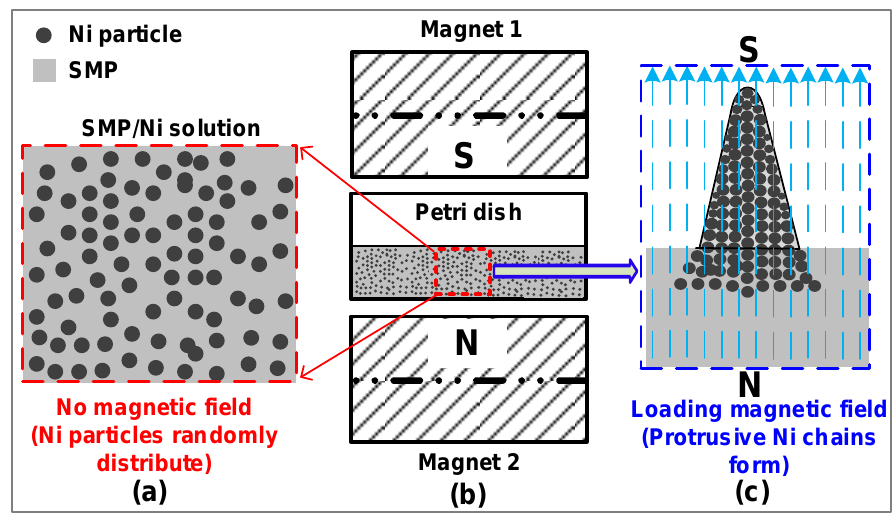
Figure 1. Illustration of preparation setup for vertical protrusive Shape Memory Polymer / Nickel (SMP / Ni) chains. ( a ) Random distribution of SMP / Ni solution without applying magnetic field; ( b ) Setup for preparing SMP / Ni vertical chain arrays; ( c ) Formation of SMP / Ni vertical chain arrays with applying magnetic field.